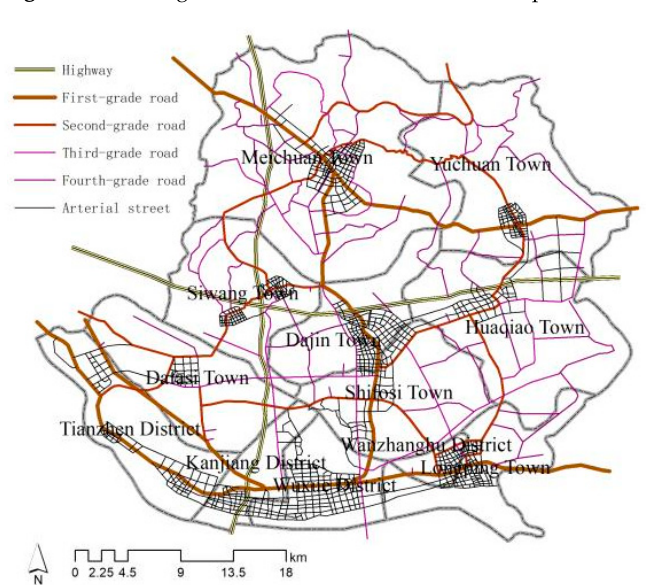
Figure 2. Planning road network.